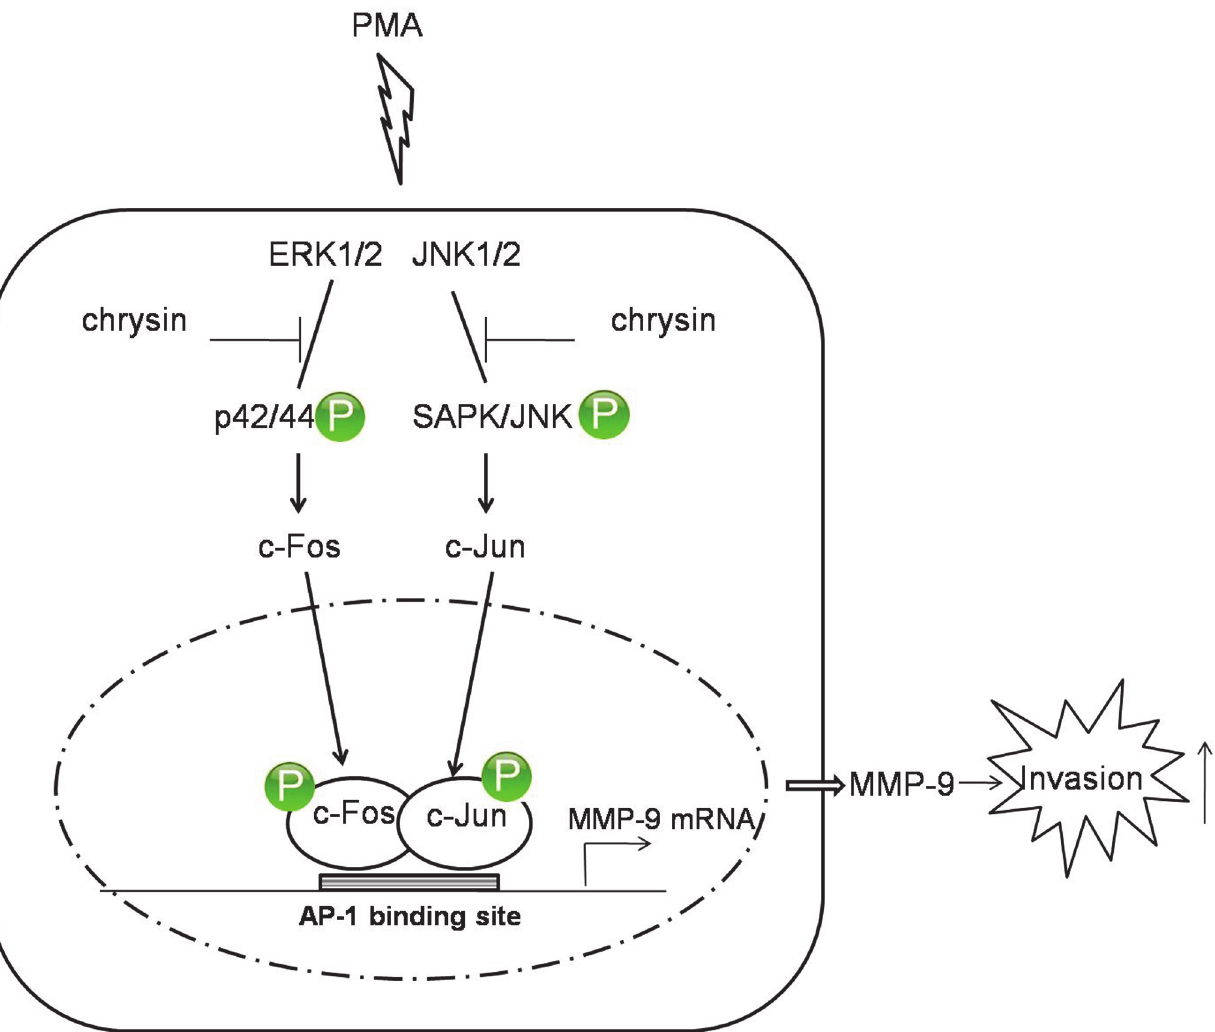
Fig 5. Schematic model of the signaling pathways involved in chrysin inhibiting PMA-induced MMP-9 expression. PMA stimulates ERK1/2 and JNK1/2 phosphorylation, in turn activating c-Fos and c-Jun, respectively. The phosphorylated c-Fos and c-Jun are translated into the nucleus, where they cooperatively bind to AP-1 binding site, thereby triggering MMP-9 gene expression. The higher level of MMP-9 expression enhances the degradation of the matrix and increases the cell invasiveness. In this model, chrysin acts as an inhibitor of the JNK1/2 and ERK1/2 signaling pathways, and decreases PMA- induced MMP-9 via suppressing AP-1